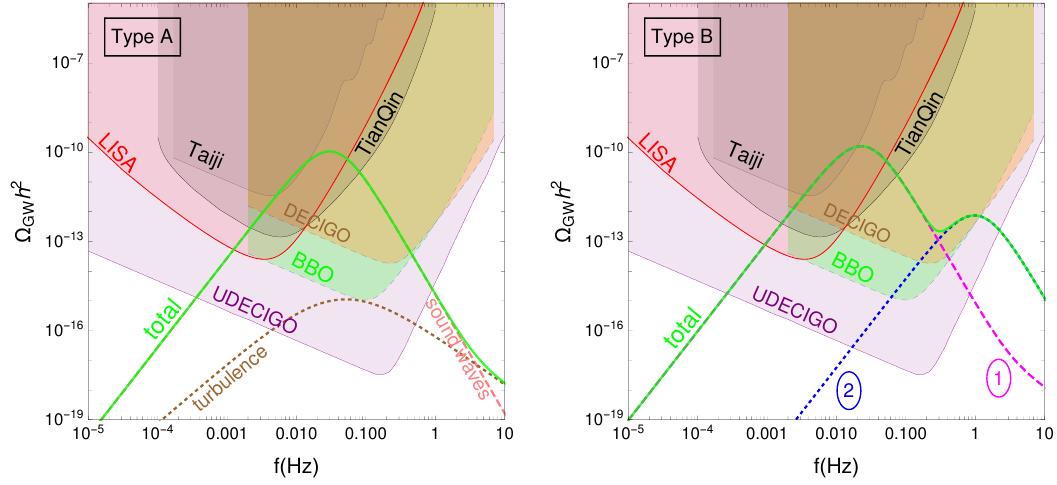
Figure 3 . Examples showing GW energy density spectra from one step (left) and two-step (right) EWPT. For the left panel, the individual contributions from sound waves and magnetohydrody- namic turbulence are shown with their sum denoted by the green solid line. For the right panel, the total contributions from both the (cid:12)rst step and second step are shown and with their sum denoted by the green solid